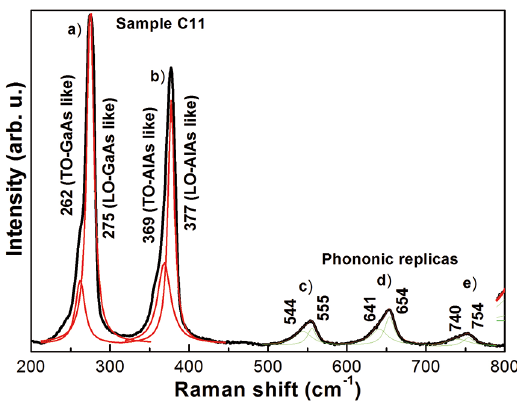
Figure 4: Typical Raman spectrum of Al grown using metallic arsenic as precursor of arsenic.